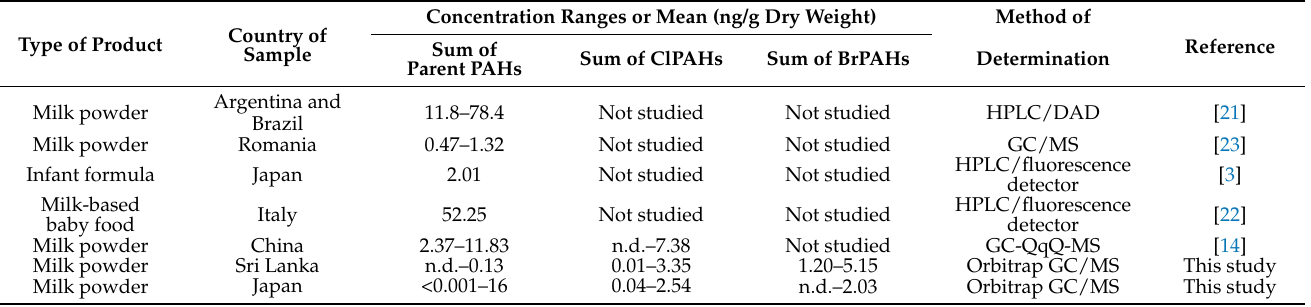
Table 1. Range or mean level of total parent, chlorinated, and brominated PAHs in milk